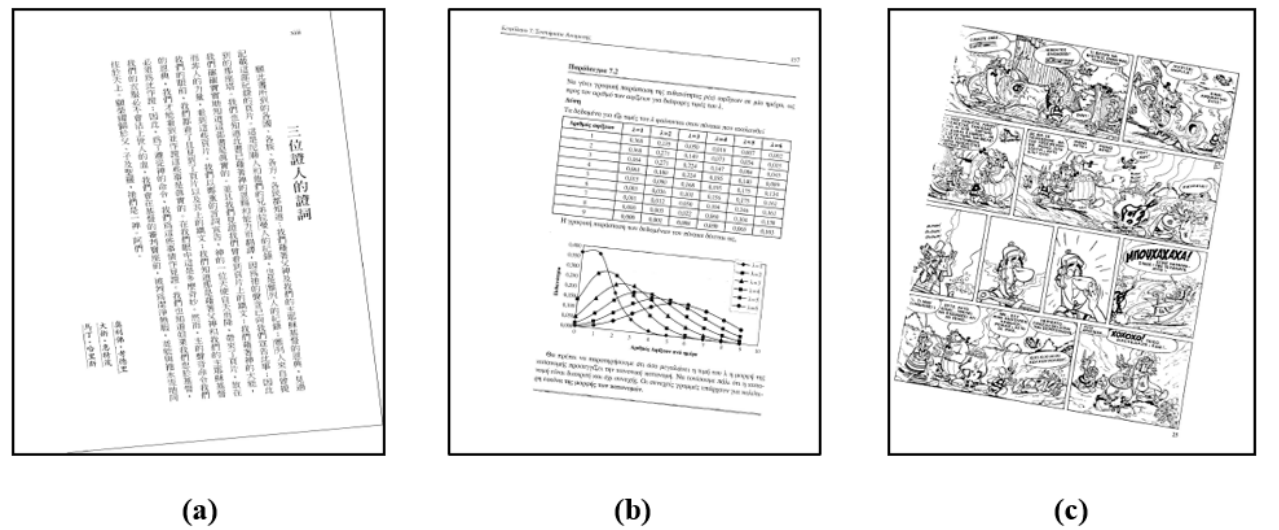
Figure 3. Results of image classification. ( a ) Text image ( b ) Form image ( c ) Complex content image.